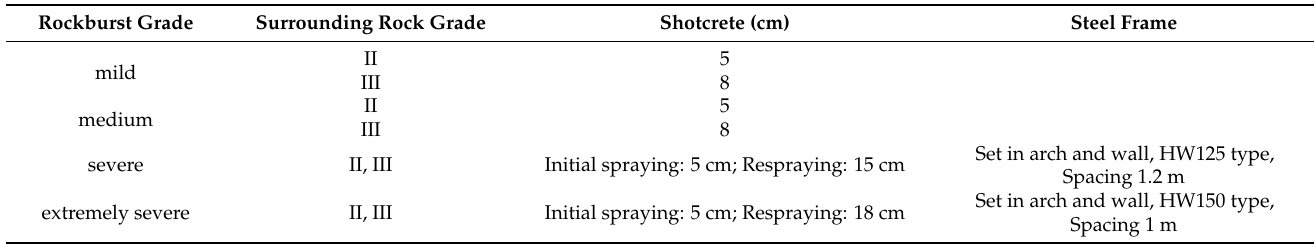
Table 9. Supporting parameters of the rockburst section in single-track by drilling and blasting method.